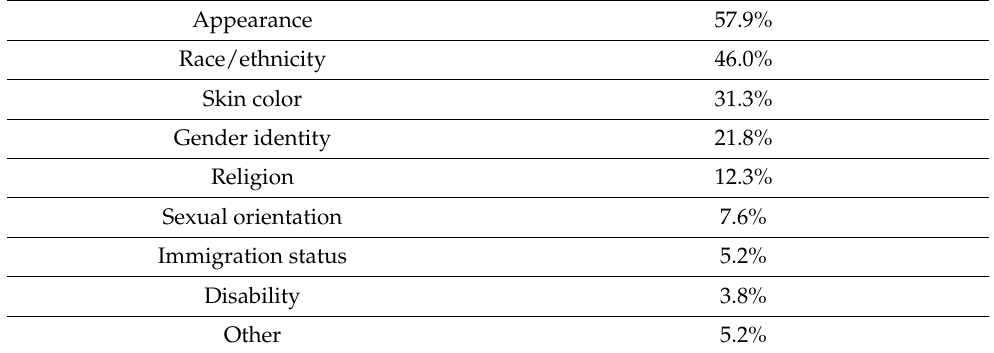
Table 2. Cited reasons for discrimination among study